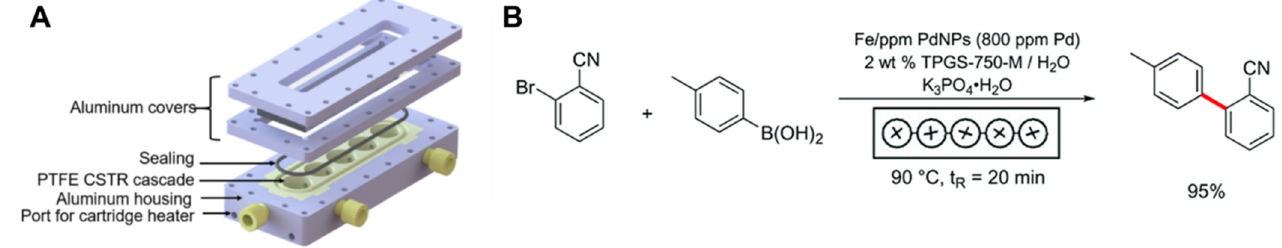
Figure 14. ( A ) Miniaturized CSTR cascade reactor. ( B ) Synthesis of a biaryl product in a continuous CSTR platform under flow conditions. Red indicates bond formed. The biaryl product is a key intermediate to sartan-containing pharmaceutical products, such as Losartan, to treat high blood pressure. Adapted with permission from [159].